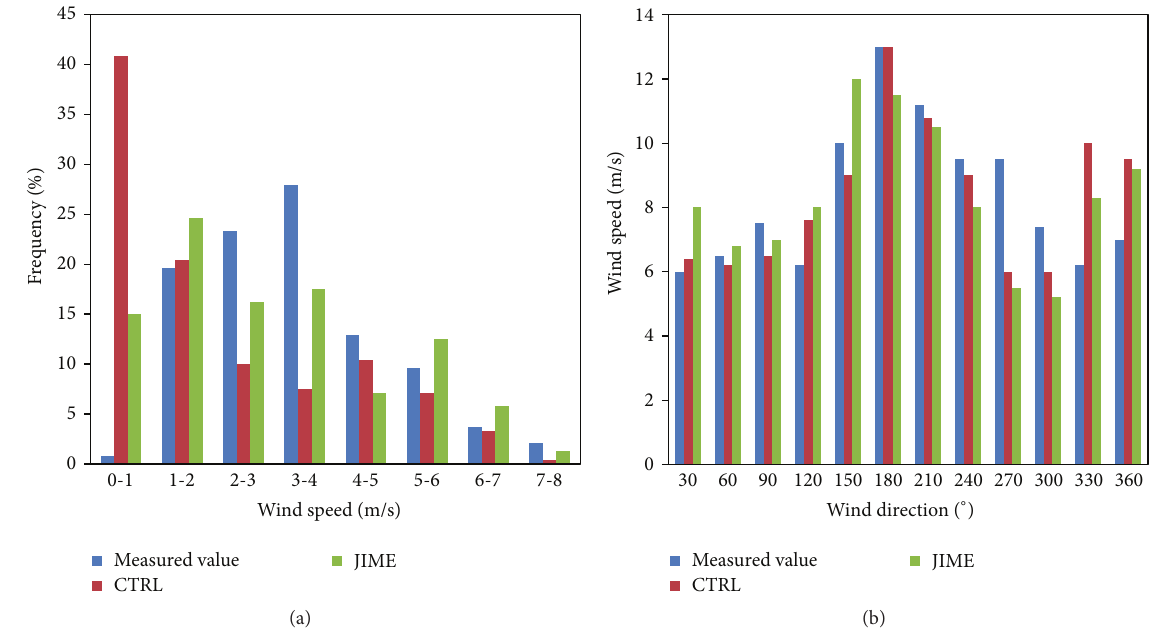
Figure 7: Figures of probability density distribution: (a) wind speed and (b) wind direction.